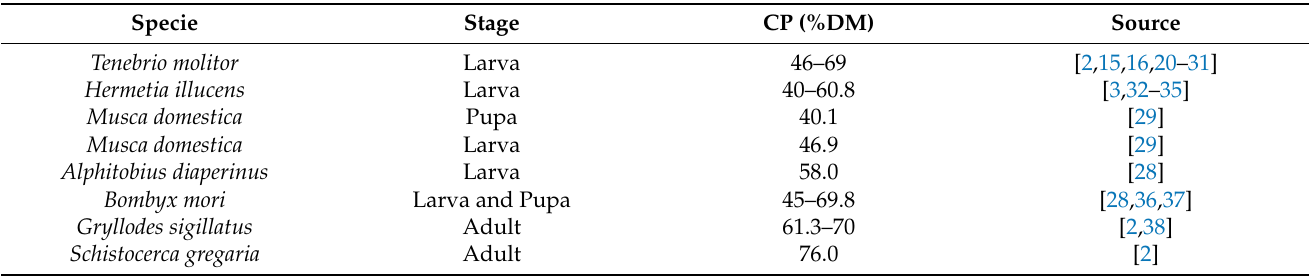
Table 1. Crude protein content (%DM) of the insect species most frequently used as